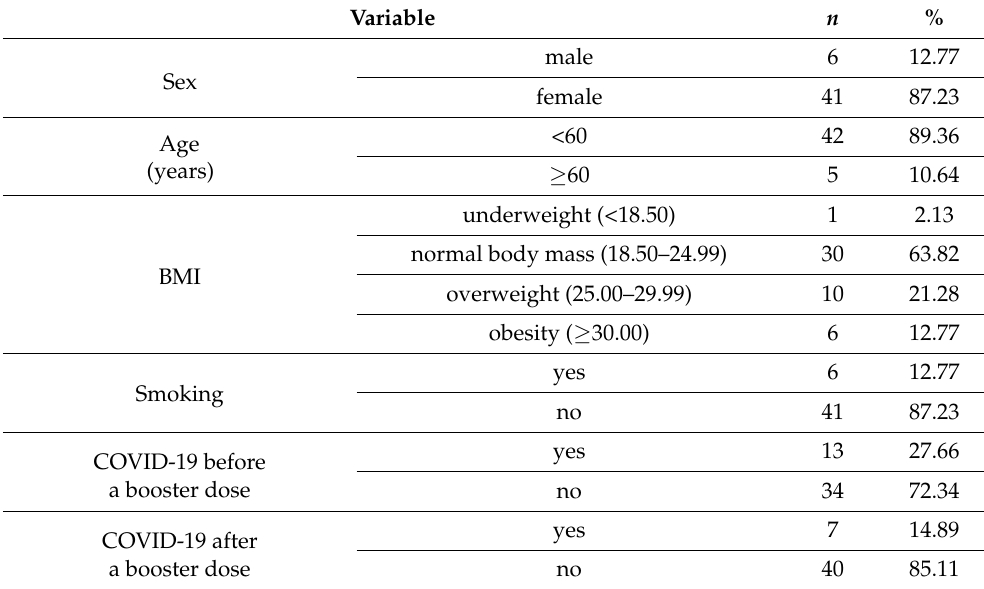
Table 1. Basic demographic and clinical characteristics of the studied